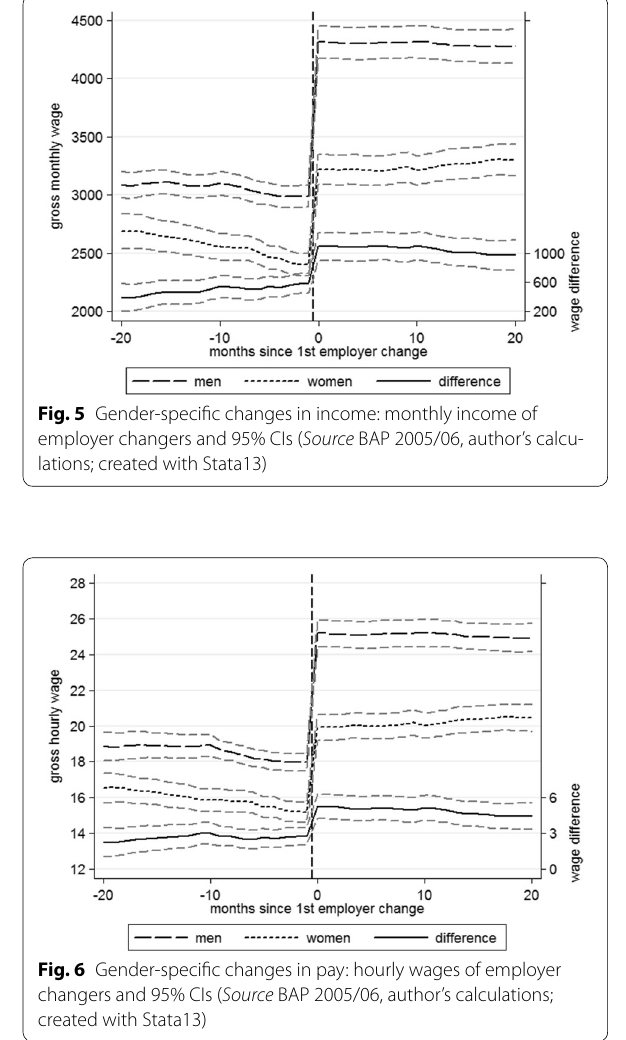
Table 6 Fixed-effects-regression models on hourly